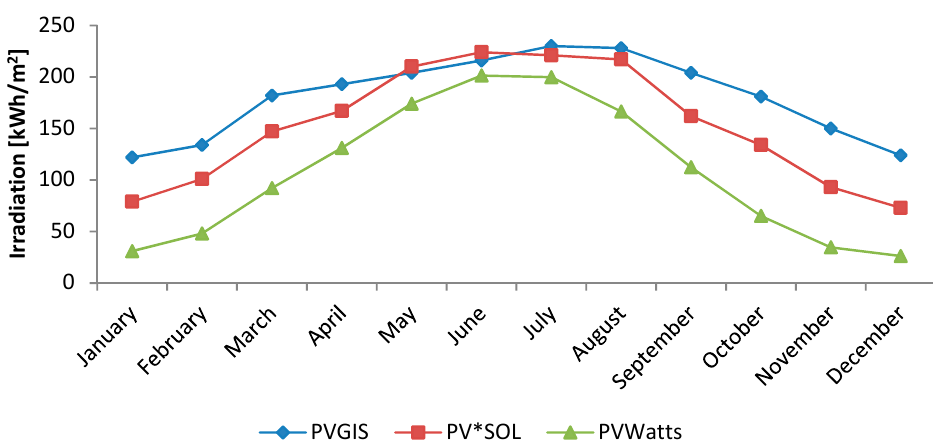
Figure 9. Monthly variation of solar irradiation for Lefko ş a.